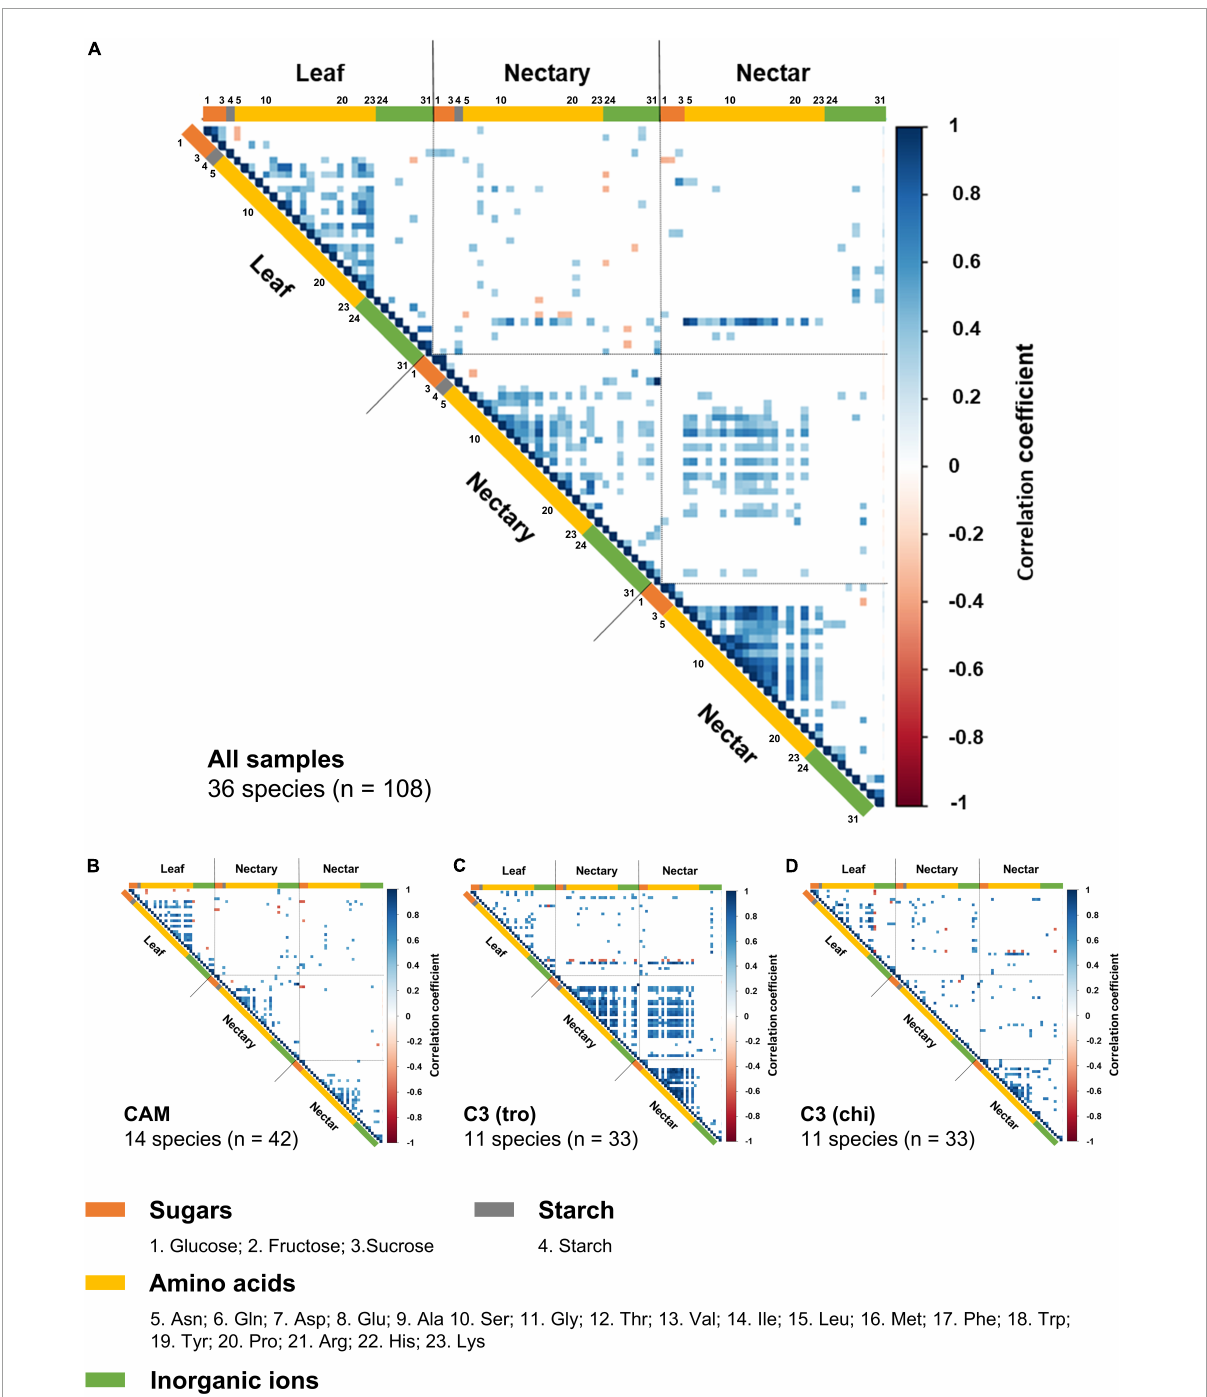
FIGURE6 Correlation heatmap for sugars, starch, amino acids, inorganic ions in leaf, nectary and nectar. The scale is colored for the value of the Pearson’s correlation coefficient. Blue represents a positive correlation while red represents negative correlation. The values of 1 and –1 marks each a perfect correlation. The correlation heatmap is divided according to leaf, nectaries and nectar. The numbers at the listed components indicate the order of the components in the correlation heatmap. Blank white boxes show non-significant correlations ( n = 3; p < 0.001). The first correlation heatmap (A) represents the complete data (36 species, n = 108). The smaller heatmaps show data from species with CAM-photosynthesis (B, 11 species, n = 33) or with C3-photosynthesis and trochilophilous pollination (C, 11 species, n = 33) or with C3-photosynthesis and chiropterophilous pollination (D , 11 species, n =